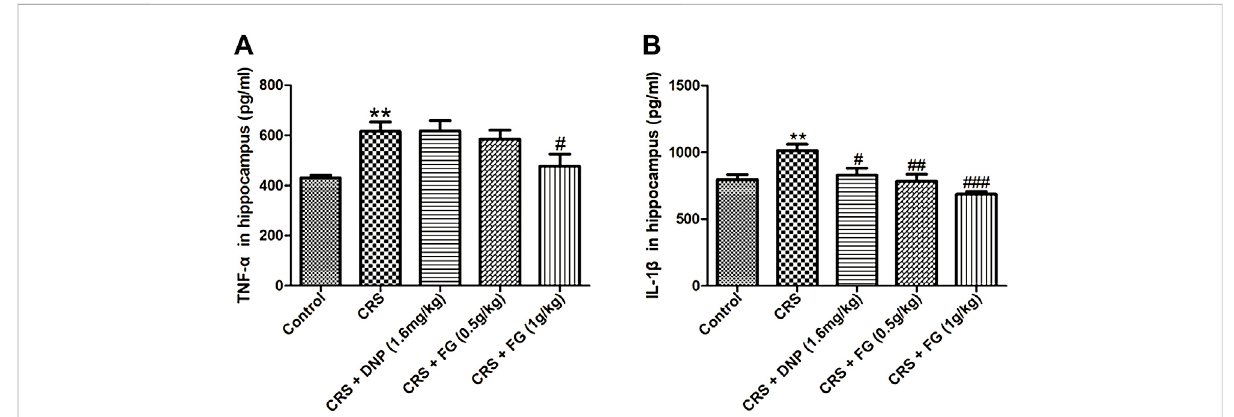
FIGURE 8 Effects of CRS, FG, and DNP on in fl ammation in serum of CRS-treated mice. (A) TNF- α and (B) IL-1 β in serum. Values represent the mean ± S.E.M. n = 6 ~ 8 mice/group. ** p < 0.01 compared with the control group; # p < 0.05, ### p < 0.001 compared with the CRS